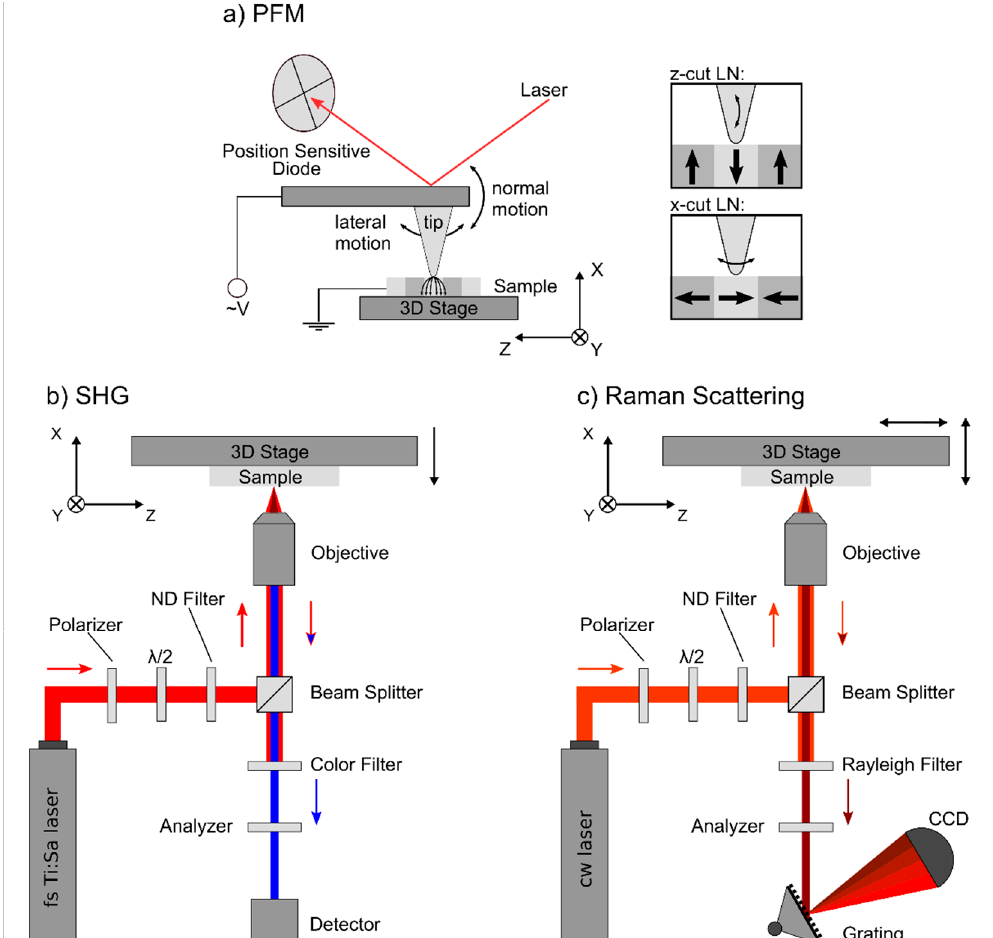
Figure 2. Schematic drawings of the different tools and setups as applied for imaging x-cut TFLN in this work. ( a ) In piezoresponse force microscopy (PFM), the normal or lateral motion of the cantilever tip is induced by the piezoelectric response to an electric field applied between the conductive tip and (insulating) sample. Insets to the right: Polarization directions and respective main tip motions for t-cut and x-cut LN samples. ( b ) In second-harmonic generation (SHG), the fundamental laser light is focused onto the sample through an objective, while the backscattered SH signal is collected via the same objective. Light with the fundamental wavelength is blocked via color filters, allowing only the second-harmonic signal to be detected. ( c ) The cw laser in the Raman backscattering setup is polarized, focused, and recollected analogously to (b). The Rayleigh filter blocks off most incident light (Rayleigh scattering), while the scattered “Raman” light is spectrally analyzed using a grating and appropriate charge-coupled device (CCD) camera.